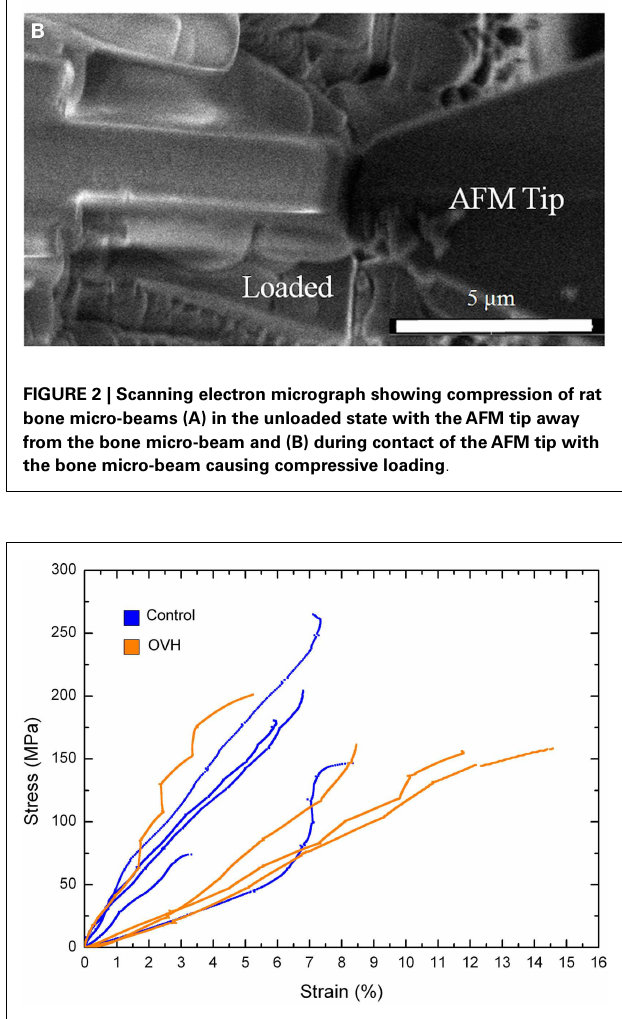
FIGURE 3 | Stress–strain curves for compression of control and ovariectomized (OVH) rat bone micro-beams .